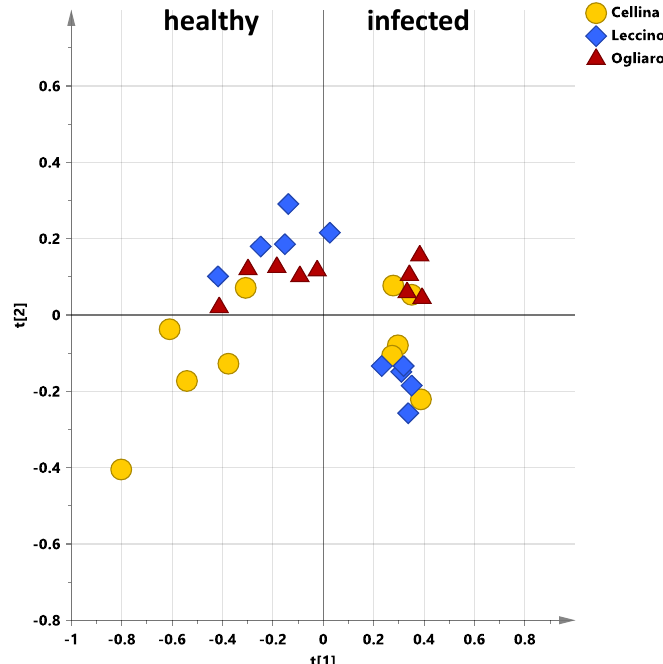
Figure 10. PCA t[1]/t[2] scores plot (three components gave R2X = 0.783 and Q2 = 0.631) for healthy and naturally infected Leccino, Cellina di Nardò and Ogliarola salentina leaf samples collected in the early springtime sampling. Healthy and naturally infected samples were collected in Grottaglie (Taranto province) and Galatone (Lecce Province), respectively. Different symbol styles for Leccino (diamonds), Cellina di Nardò (circles) and Ogliarola salentina (triangles) are reported.